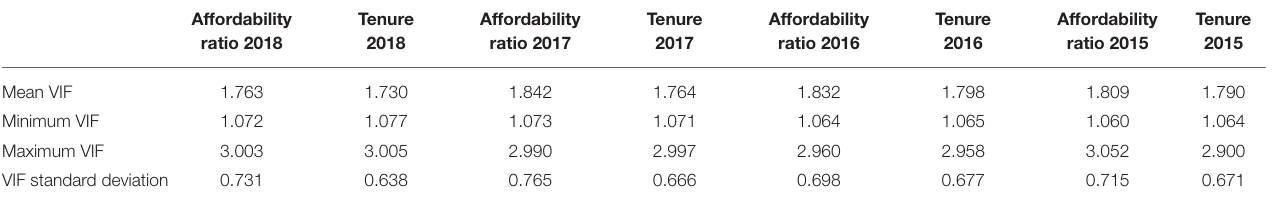
TABLE 3 | Summaries of VIF factors generated for each of the explanatory